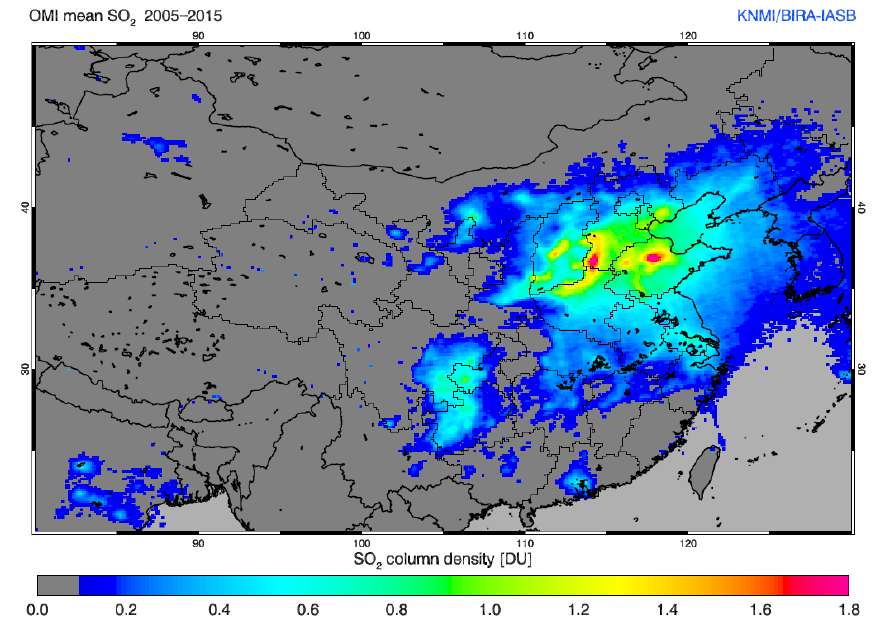
Figure 2. Average SO 2 concentrations for the period 2005 to 2015 as observed by the OMI satellite instrument. Data below 0.1DU are masked